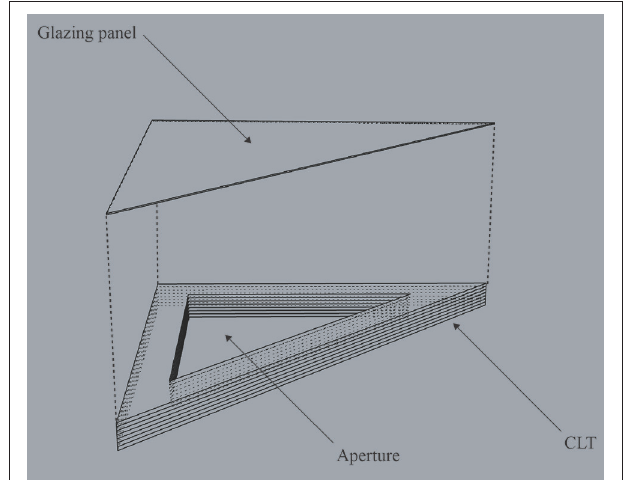
FIGURE 13 | The glazed CLT concept of Panel D.